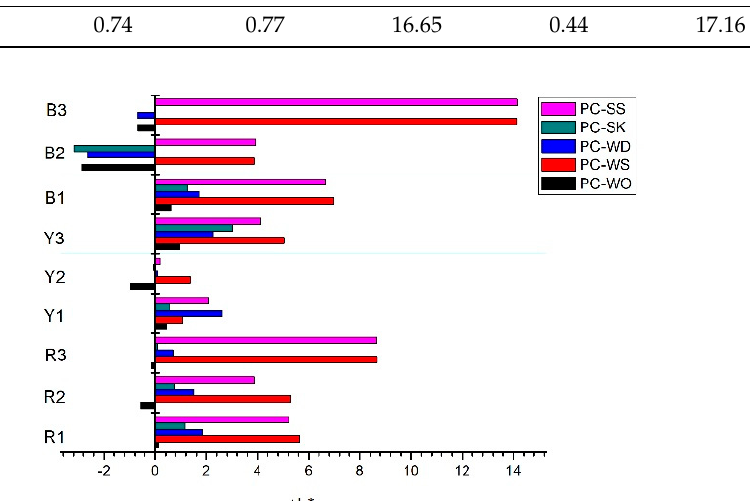
Figure 5. ∆ L* calculated using PC adjustment as the target and the other procedures as Figure 5. Δ L* calculated using PC adjustment as the target and the other procedures as samples.